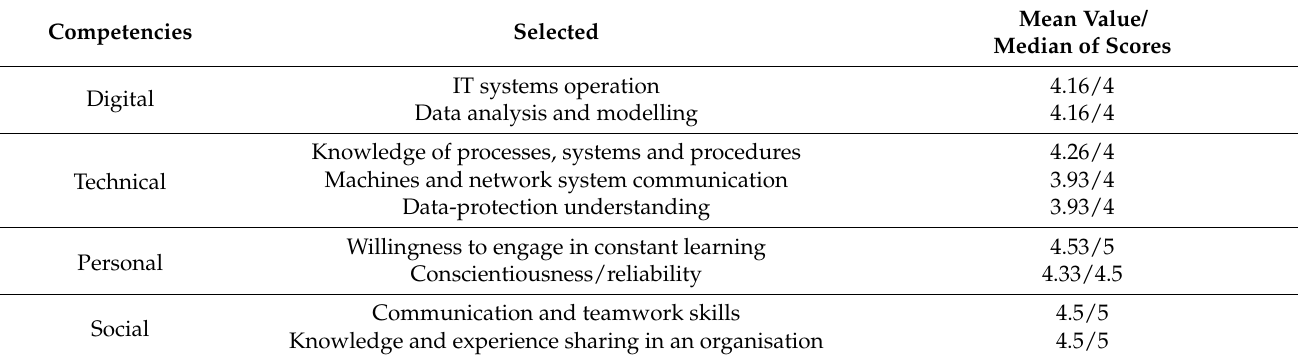
Table 3. The most popular competencies in employee trial.